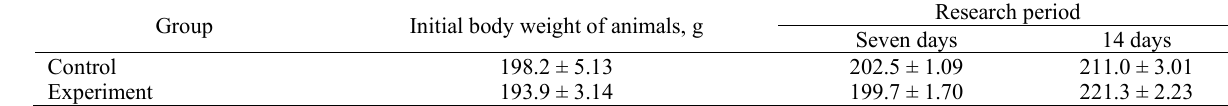
Dynamics of changes in body weight during 14- day application of ointment on the skin of white rats (М ± m, n = 5)